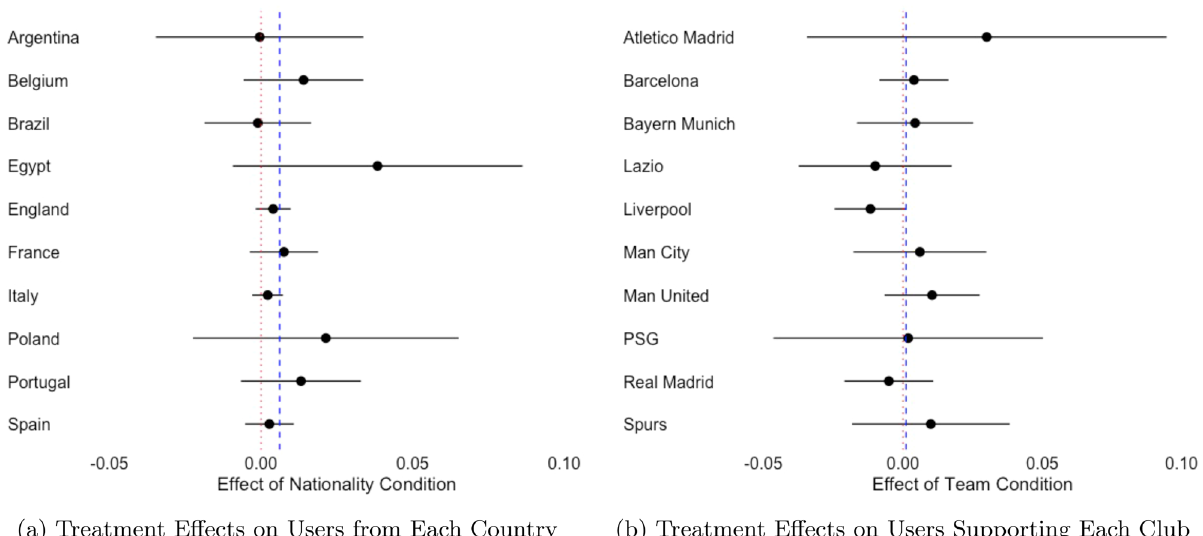
Figure 4. The dots represent the estimated treatment effect with 95% confidence intervals around them. The blue line represents the estimated treatment effect based on the entire